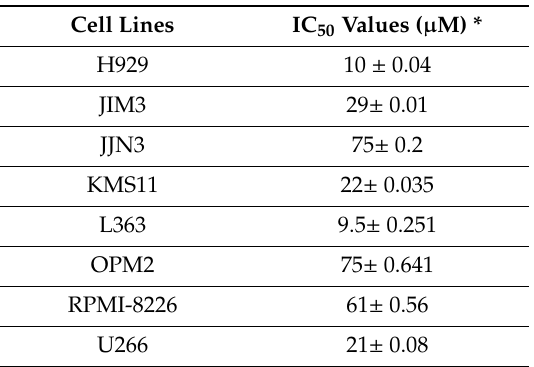
Table 1. IC 50 values of GSK2606414-treated cells at 48 h